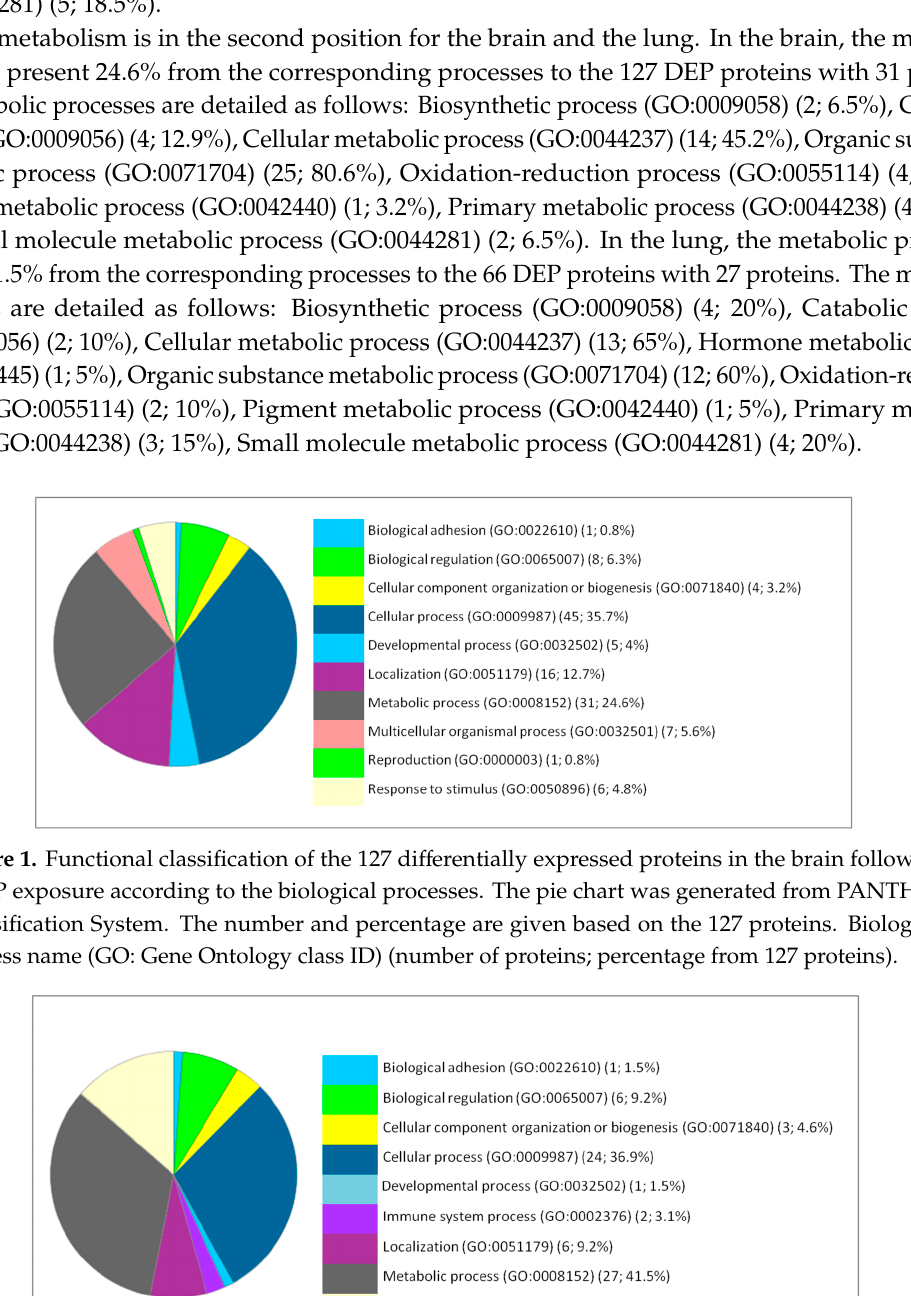
Figure 3. Functional classification of the 84 differentially expressed proteins in the lung following IONP exposure according to the biological processes. The pie chart was generated from PANTHER